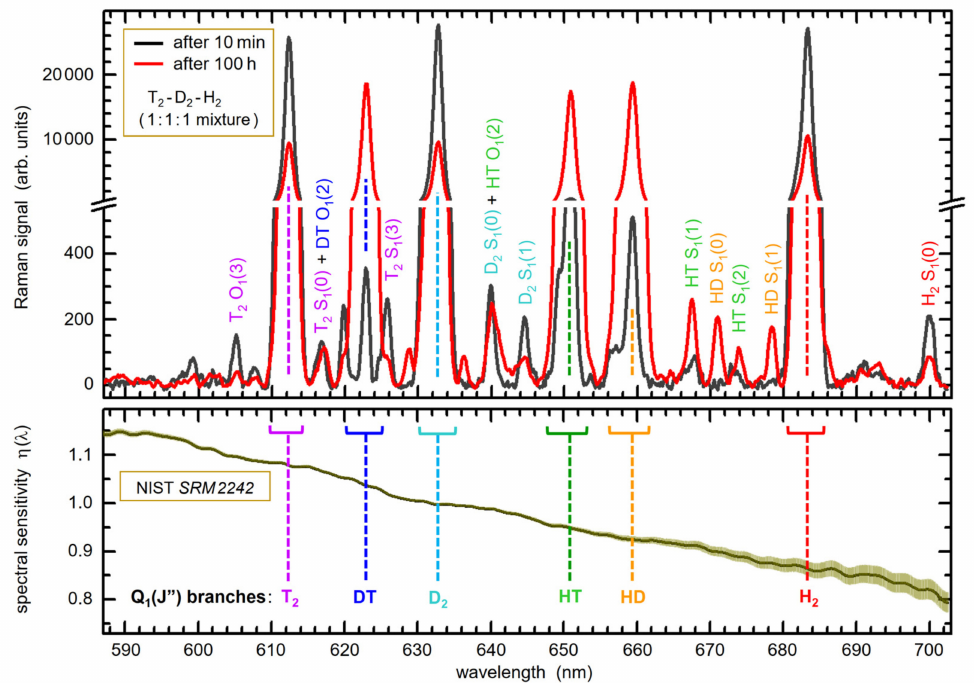
Figure 1. Example Raman spectra of a H 2 -D 2 -T 2 mixture (ratio 1:1:1) circulating in TRIHYDE, recorded at the beginning (black data trace) and after 100 h of circulation (red data trace); note that the Raman signal data shown here represent averages over 10 Raman measurement cycles of 1 min each. The Q 1 -branches of the six isotopologues, used in the evaluation of concentrations, are annotated (the peak positions by the dashed lines and the band integration intervals by associated brackets). The other features are S 1 - and O 1 -branch lines (to maintain clarity, only a few selected lines are annotated). In the lower panel, the spectral sensitivity calibration for LARA TRIHYDE is shown (normalization at λ = 633 nm); the “raw” Raman spectra were corrected using this response function, resulting in the displayed spectra. For full details, see Section